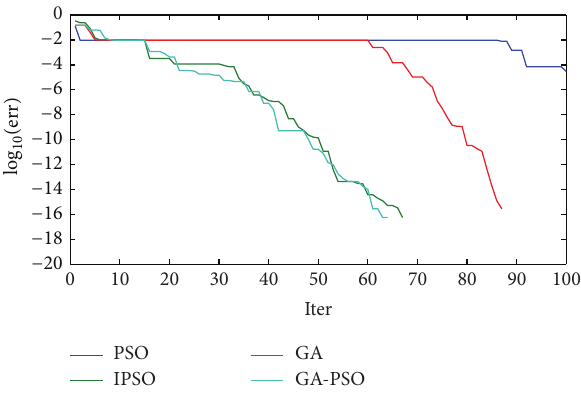
Figure 6: Curves comparison of fitness value.